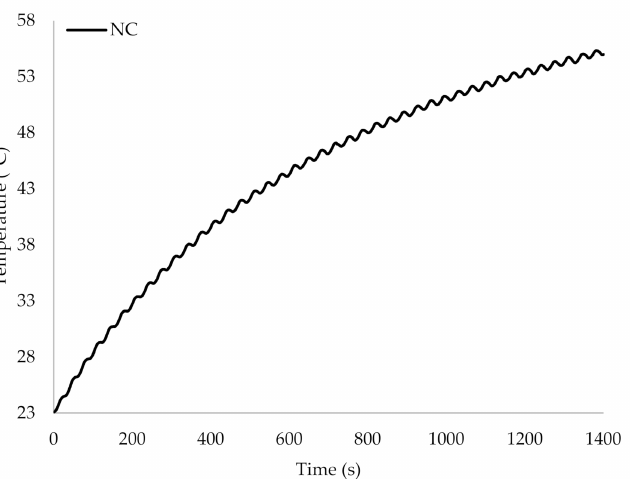
Figure 3. Temperature evolution of the LiC cell under 150 A current rate when there is no cooling system (under natural convection